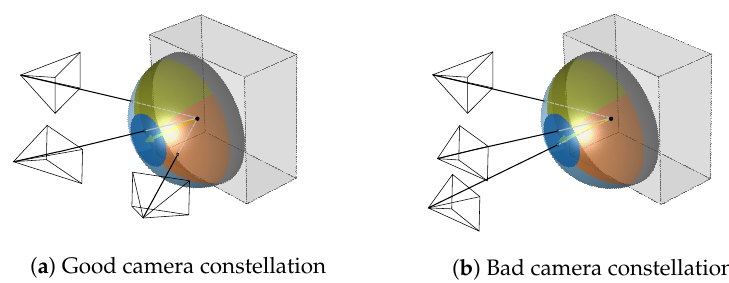
Figure 5. Observation angle segments for two camera constellations. A hemisphere is generated along the objects point normal vector and divided into different segments. Each camera ray intersects the hemisphere in a specific segment. Good camera constellations intersect the hemisphere in different segments ( a ), while camera pairs with ego-motion and small baselines intersect in the same segment ( b